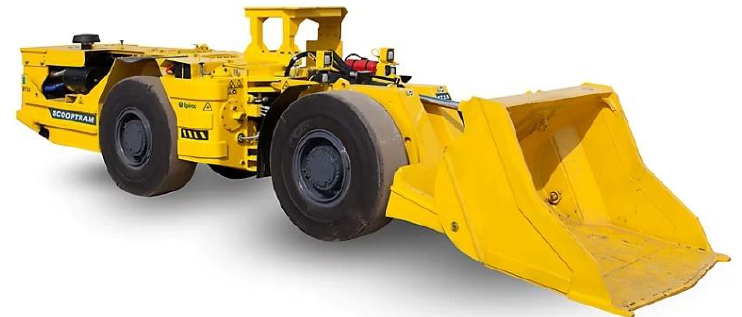
Figure 12. Scooptram ST3.5 diesel LHD. Table 2. Parameters of the Scooptram ST3.5 diesel LHD.